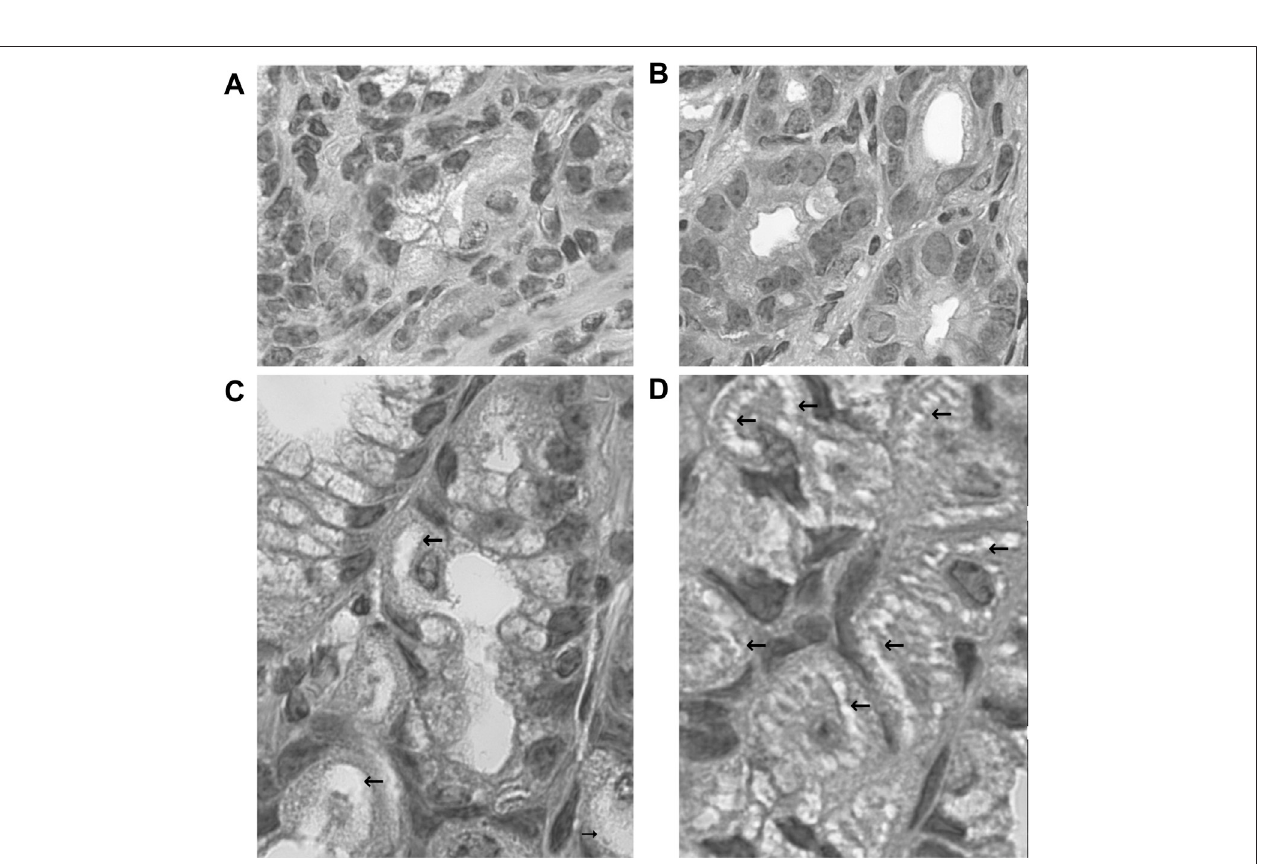
FIGURE4| MorphologicalchangesoffundicglandularcellsbyacidsuppressantsunderNHPHinfection.HEstains (A) thecontrolgroupfundicmucosa,X400. (B) In famotidine-treated mice, no signi fi cant changes in the parietal cell were detected in the body portion of the fundic gland, X 400. (C) In the lansoprazole-treated mice, many parietal cells having very enlarged intracellular canaliculi (arrows) were seen, X 600. (D) In the vonoprazan-treated mice, most parietal cells had the enlarged intracellular canaliculi (arrows) surrounding the nucleus, X